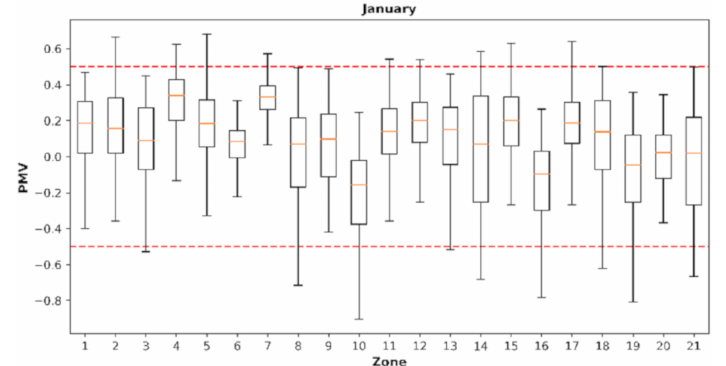
Figure A10. PMV in January.